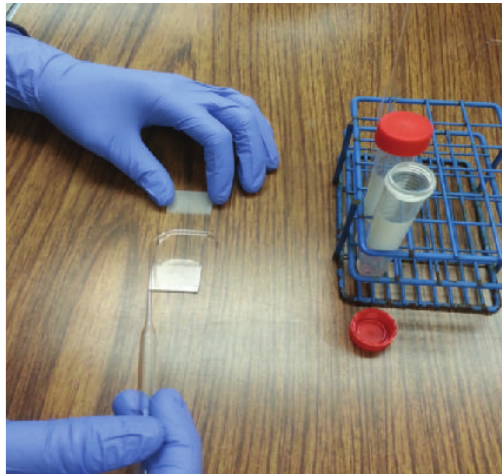
Figure 1: Spreading cells on a slide with a glass spreader. The glass spreader was made from a glass transfer pipette by heating it for a few seconds to minutes over an alcohol